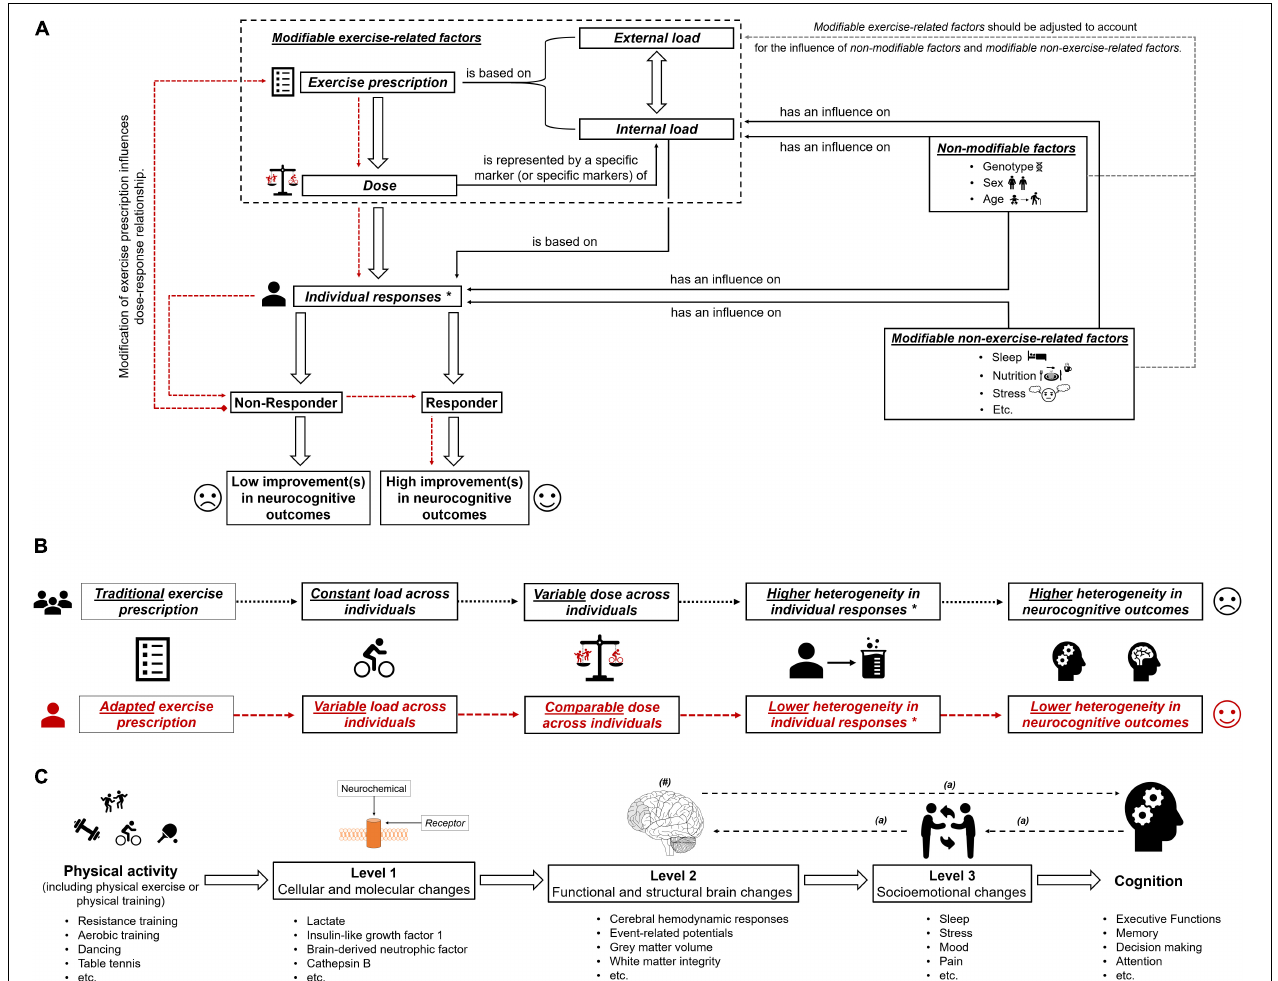
FIGURE 1 | (A) Schematic illustration of the possible influence of exercise prescription on dose, and individual responsiveness (responder and non-responder) with the assumed extent of improvements (high improvements in neurocognitive outcomes and low improvements in neurocognitive outcomes). The dotted red lines show that by using an appropriate exercise prescription, non-responders could be turned into responders. In part (B) of the figure, the difference between “traditional exercise prescription” and “adapted exercise prescription” regarding the load, the dose, the individual response(s), and the corresponding heterogeneity in outcomes is illustrated. “ ∗ ” with regard to subsequent neurobiological processes. In part (C) of the figure, the multiple levels on which physical activity (including physical exercise and physical training) could affect cognitive performance are shown (Stillman et al., 2016). “#” indicates that the brain could be seen as outcome, mediator, or predictor (Stillman and Erickson, 2018). “a” indicates that there are several possibilities in which way structural and functional brain changes, socioemotional changes and cognitive changes are intertwined (Stillman et al.,